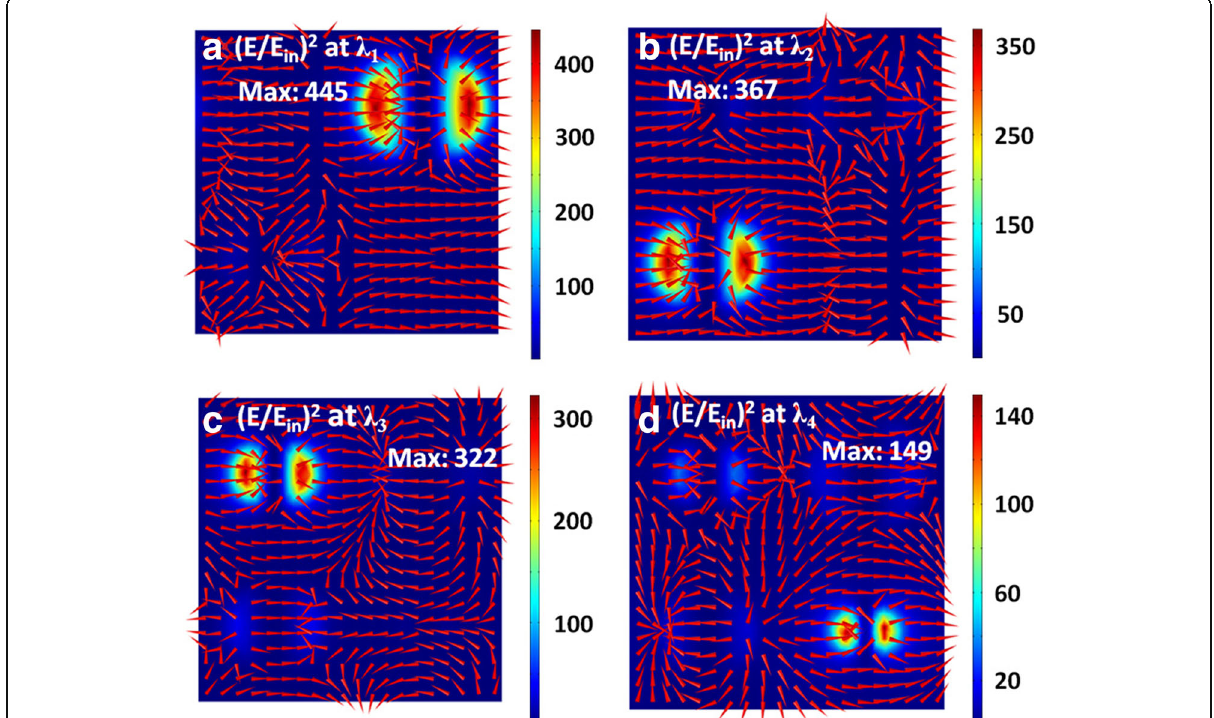
Fig. 3 ( a )-( d ) Corresponding normalized electric field intensity ( E / E in ) on the xoz plane across the center of the SiO spacer for the resonance wavelengths of λ , λ , λ , and λ labeled in Fig. 2. Red arrows represent the field direction, and colors show the field